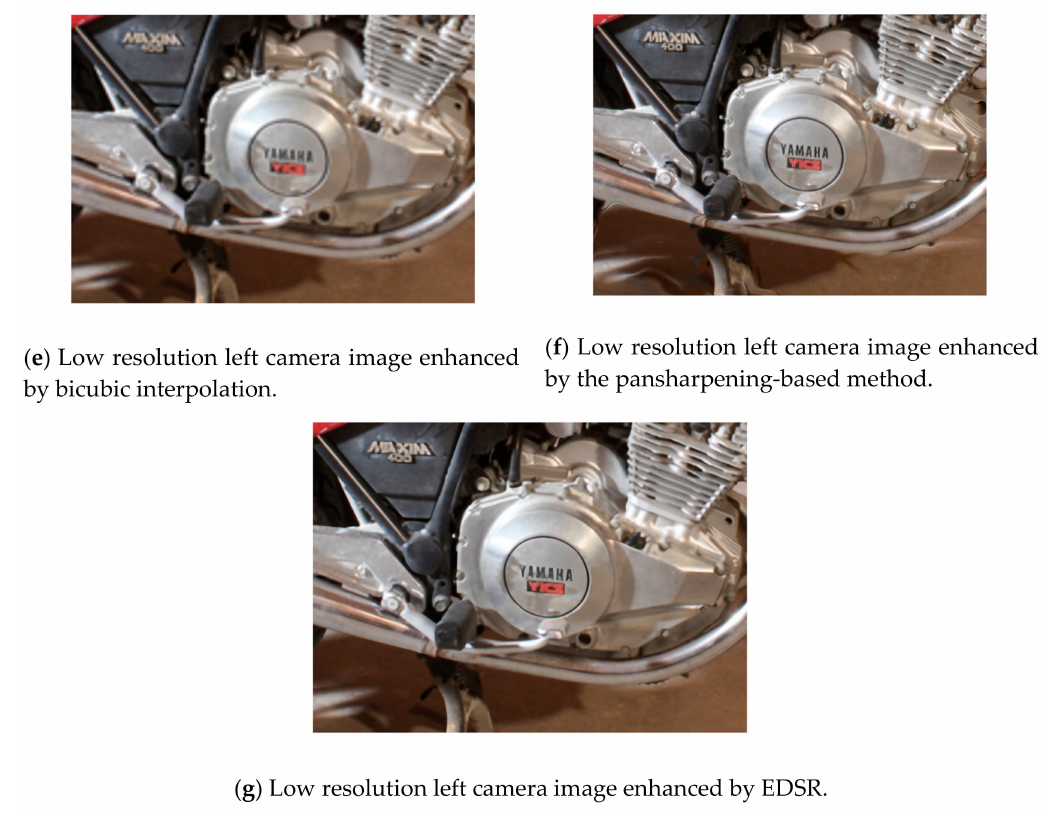
Figure 7. A section of the motorcycle stereo image pair and the enhanced left camera images with the three methods.